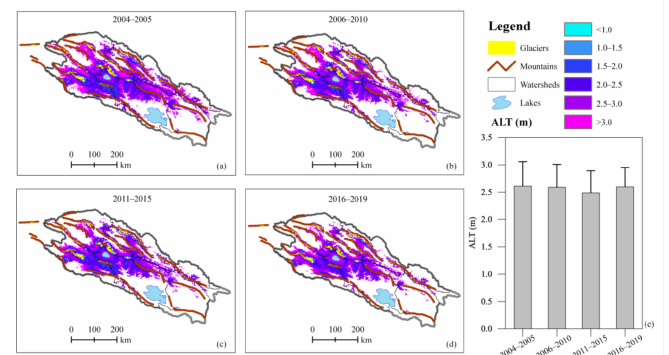
Figure 7. Temporal variations of active layer thickness (ALT, m) in the Qilian Mountains from 2004 to